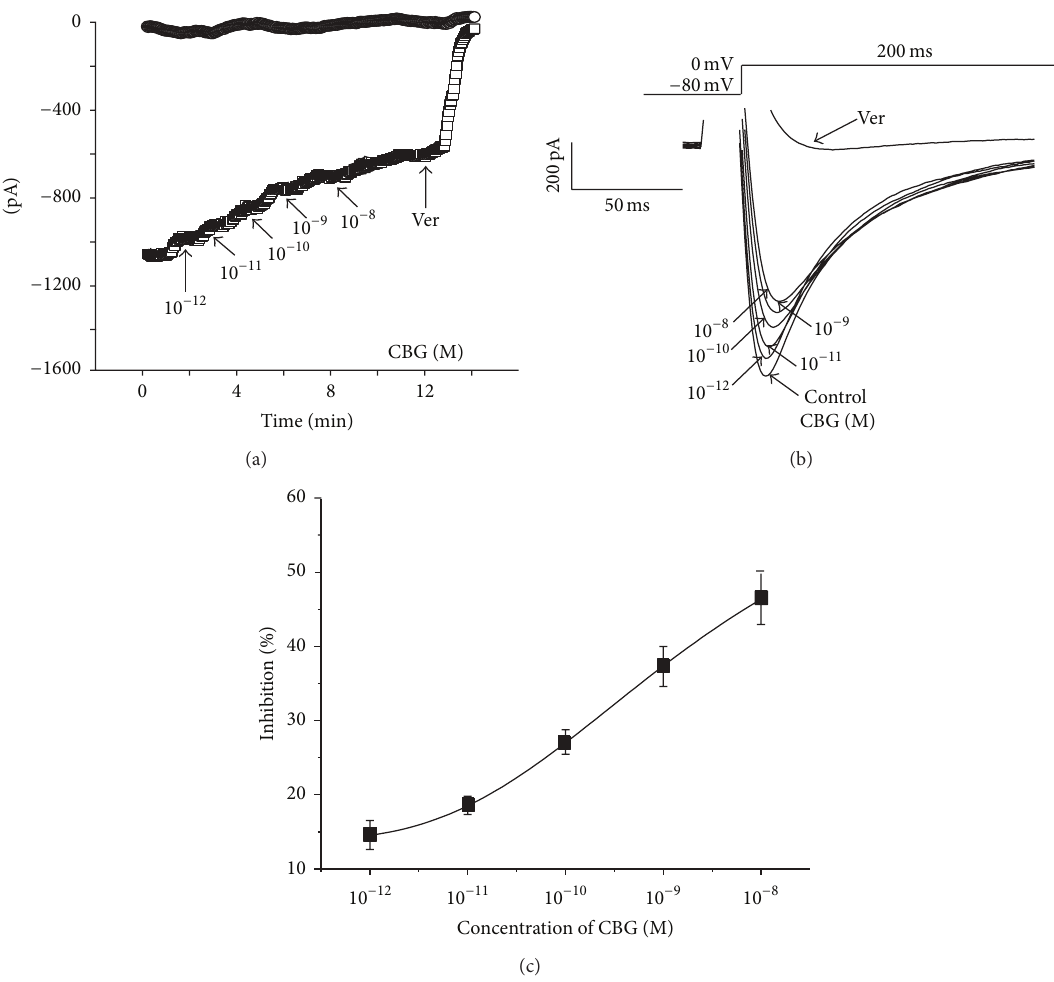
Figure 3: CBG dose-dependently inhibits 𝐼 10 −10 , 10 −9 , and 10 −8 M CBG and 0.1mM Ver. (b) Traces of 𝐼 curve demonstrating the inhibitory effects of CBG on 𝐼